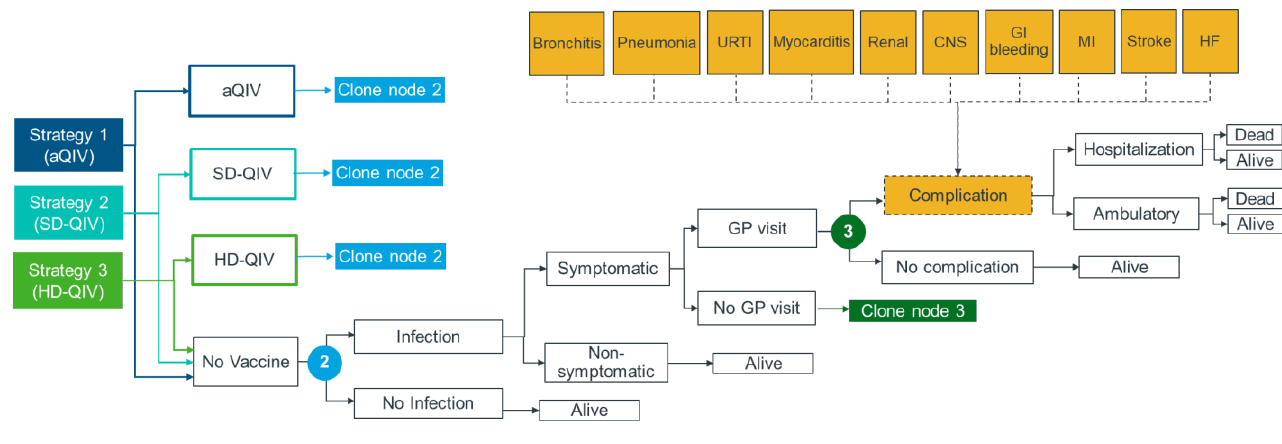
Figure 1. Model structure.